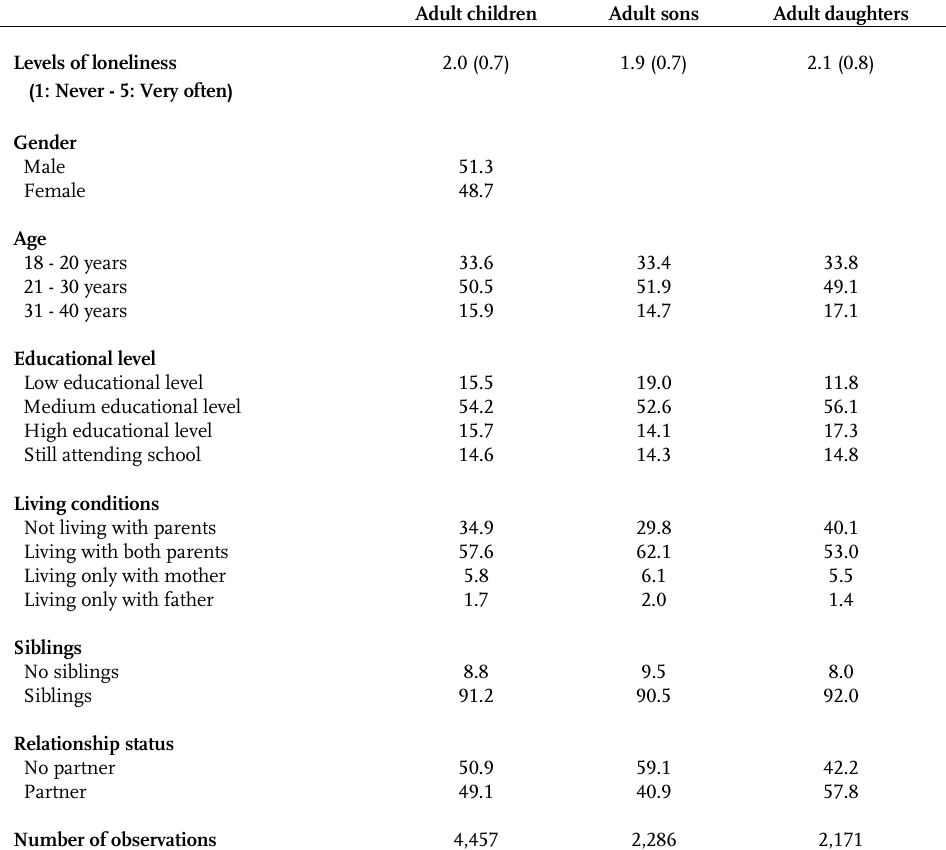
Table 1 : Descriptive sample statistics for adult children: Percentages or means (standard deviations) Adult children Adult sons Adult daughters